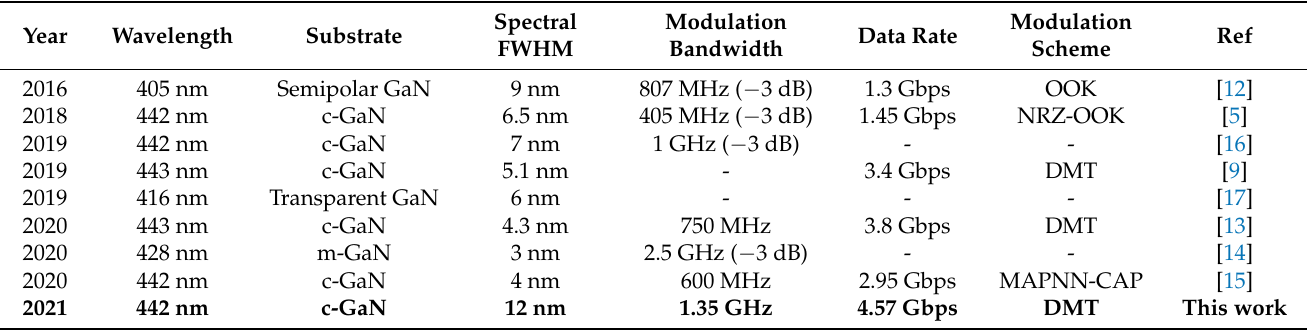
Table 1. Comparison of GaN-based SLDs for VLC